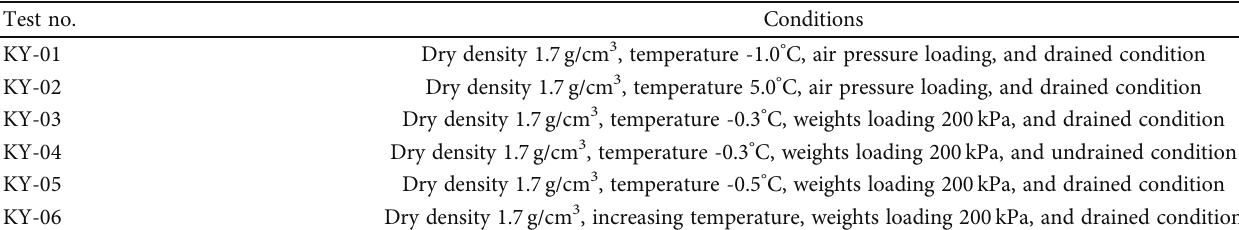
Table 3: Test conditions for each sample.